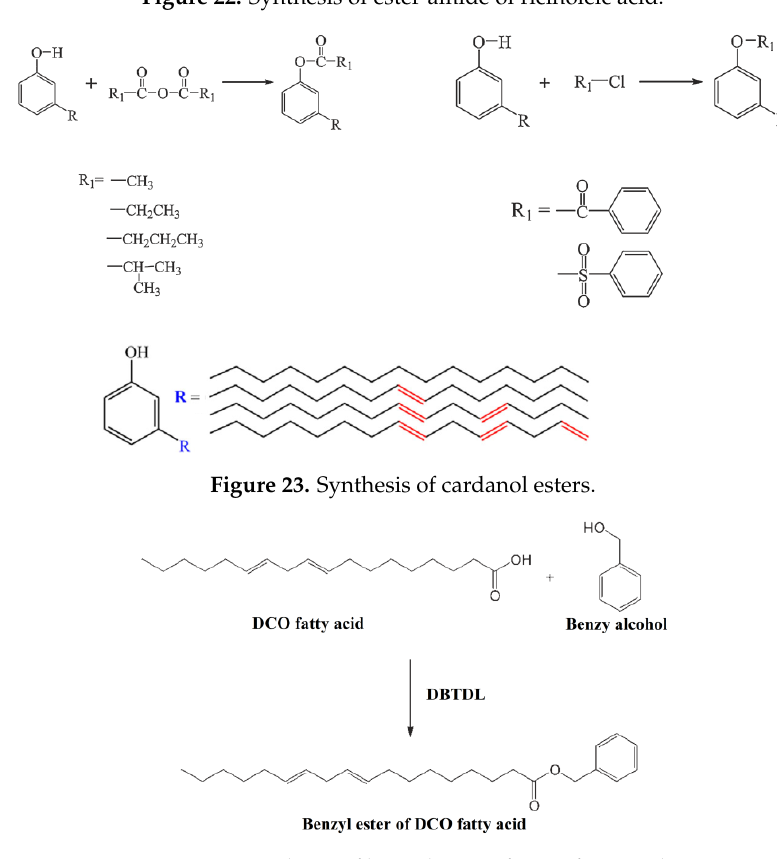
Figure 24. Synthesis of benzyl ester of DCO fatty acid.